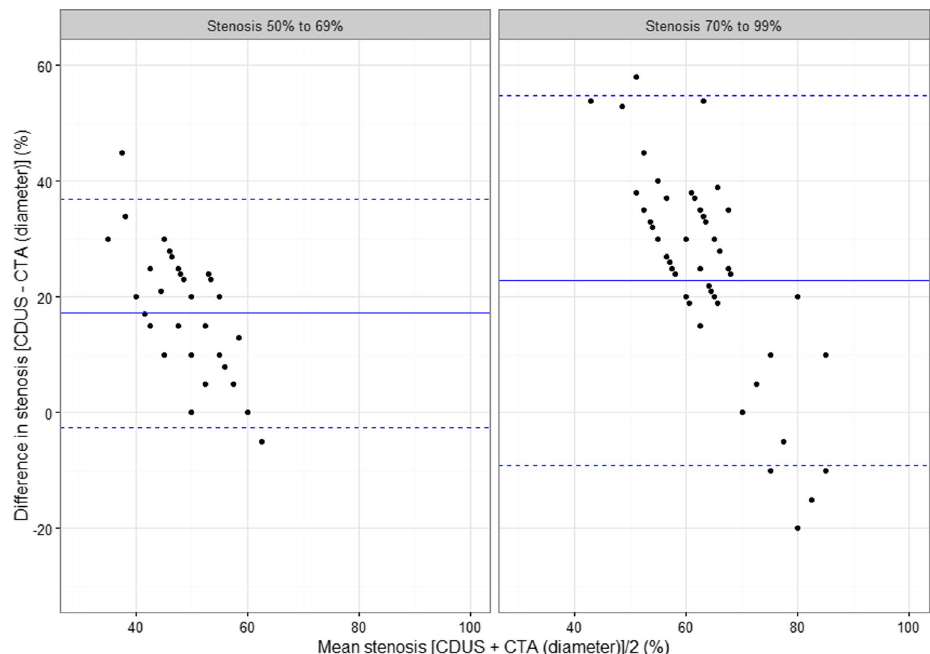
Fig. 4 Bland-Altman plot of the difference between CDUS- and CTA (diameter)-based